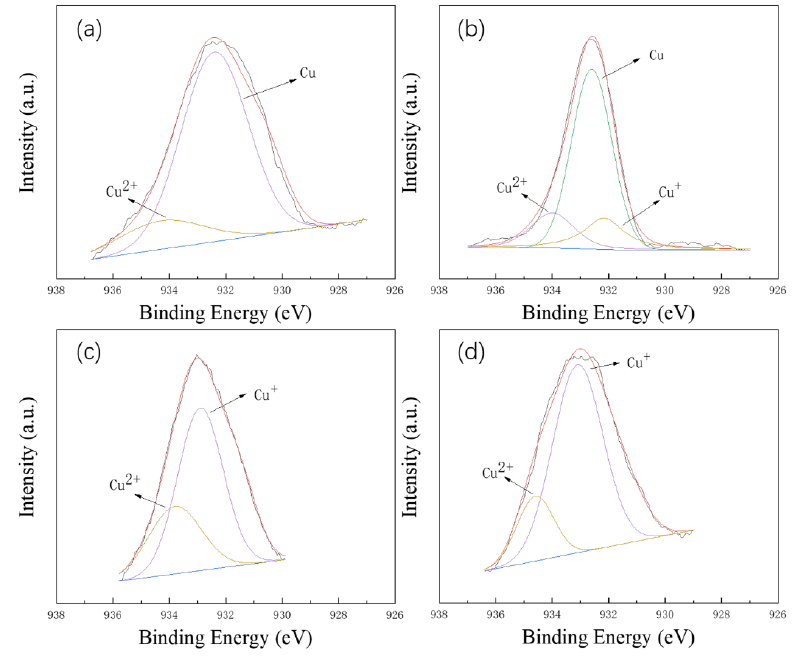
Figure 9. X-ray photoelectron spectroscopy analyses on Cu of ( a ) as-received 304Cu, ( b ) 304Cu after 168 h salt spray tests, ( c ) 304Cu after 480 h salt spray tests and ( d ) 304Cu after 72 h FeCl 3